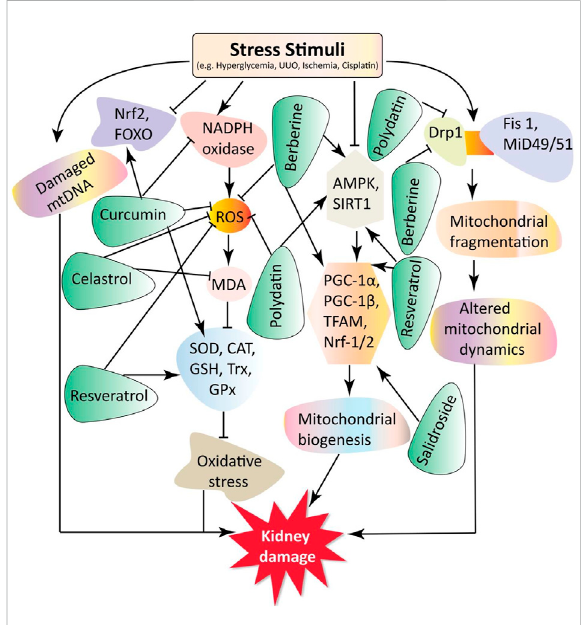
FIGURE 2 Thisschematicrepresentationindicatesthatstressstimulilike HG, UUO, cisplatin, and ischemia regulate various pathological conditions involving oxidative stress, mitochondrial biogenesis, mtDNA damage, and altered mitochondrial dynamics. These ultimately lead to renal damage. The small molecule rotenone reduces mtDNA damage and ROS production. In addition, celastrol reduces the ROS and MDA oxidative stress markers. Polydatin, berberine, and resveratrol decrease ROS production. Salidroside increases SIRT1 and PGC-1 α expression, resulting in mitochondrial biogenesis, enhancing and protecting the kidneys. Curcumin and resveratrol increase the transcription of antioxidants markers SOD , CAT , GSS , GPX , and Trx . Moreover, berberineandresveratrolincreasetheexpressionofmitochondrial biogenesis markers PGC-1 α , TFAM , Nrf-1 , and Nrf-2 . Furthermore, polydatin decreases the expression of mitochondrial fi ssion protein Drp1 and preserves kidney function. Key: DN, diabetic nephropathy; Drp1, dynamin-related protein 1; GSH, glutathione; GPx, glutathione peroxidase; GM, gentamycin; HN, hyperuricemic nephropathy; MDA, malondialdehyde; mtDNA, mitochondrial DNA; Nrf-1 and Nrf-2, nuclear respiratory factors 1 and 2; PGC-1 α , peroxisome proliferator-activated receptor- γ coactivator 1 α ; ROS, reactive oxygen species; SIRT1, silent mating type information regulation 2 homologs 1; SOD, superoxide dismutase; Trx, thioredoxin; TFAM, transcription factor A of